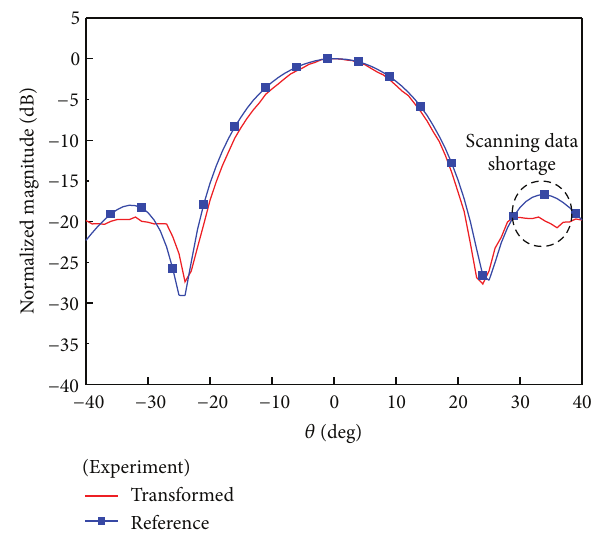
Figure 7: Transformed and reference far-field patterns from the